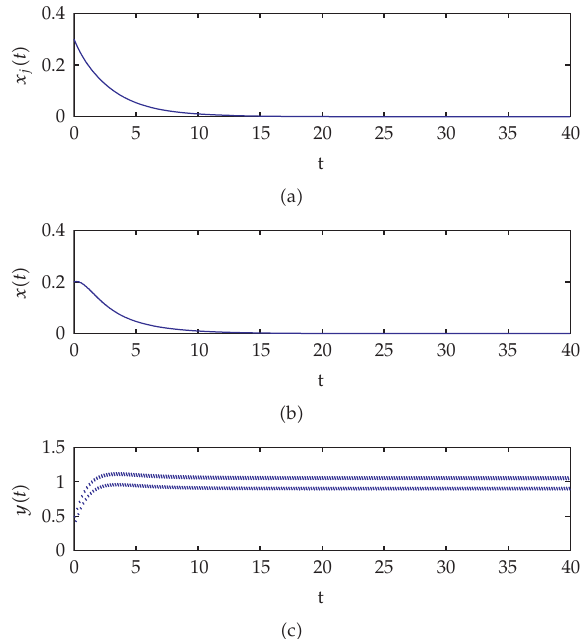
Figure 4: Time series of system (cid:3) 2.4 (cid:4) with parameters d (cid:8) 0 . 6; d 1 (cid:8) 0 . 4; α (cid:8) 0 . 8; τ (cid:8) 0 . 8; d 2 (cid:8) 0 . 5; β (cid:8) 0 . 8; λ (cid:8) 0 . 9; p (cid:8) 0 . 1; μ (cid:8) 0 . 2; T (cid:8) 0 .